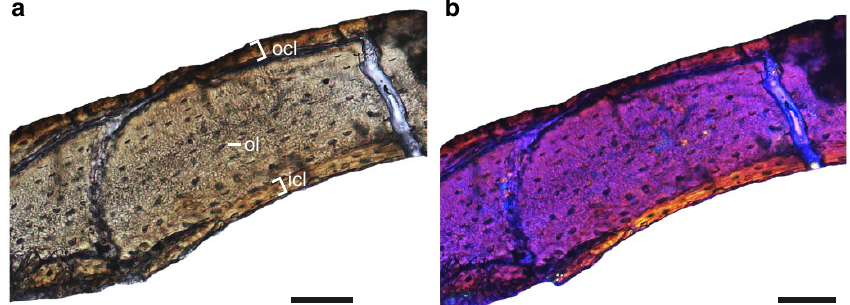
Figure 6 | Bone histology of C. multidonta holotype (IVPP V21711). ( a ) Transverse section of the right humerus under normal light, and ( b ) polarized light with l -compensator (see Supplementary Fig. 4 for complete thin section). Abbreviations: icl, inner circumferential layer; ocl, outer circumferential layer; ol, osteocyte lacunae. Scale bars, 50 m